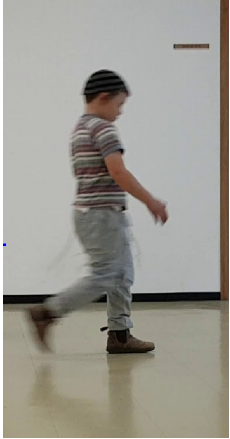
Figure 9. Detection of a walking